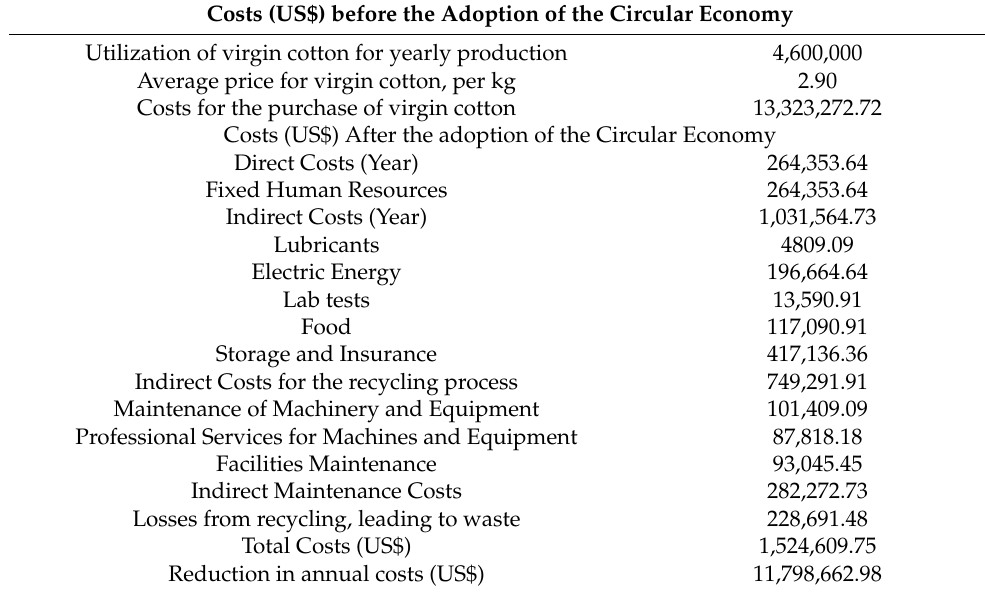
Table 5. Assessment of costs from the process of recovering textile fibres. Costs (US$) before the Adoption of the Circular